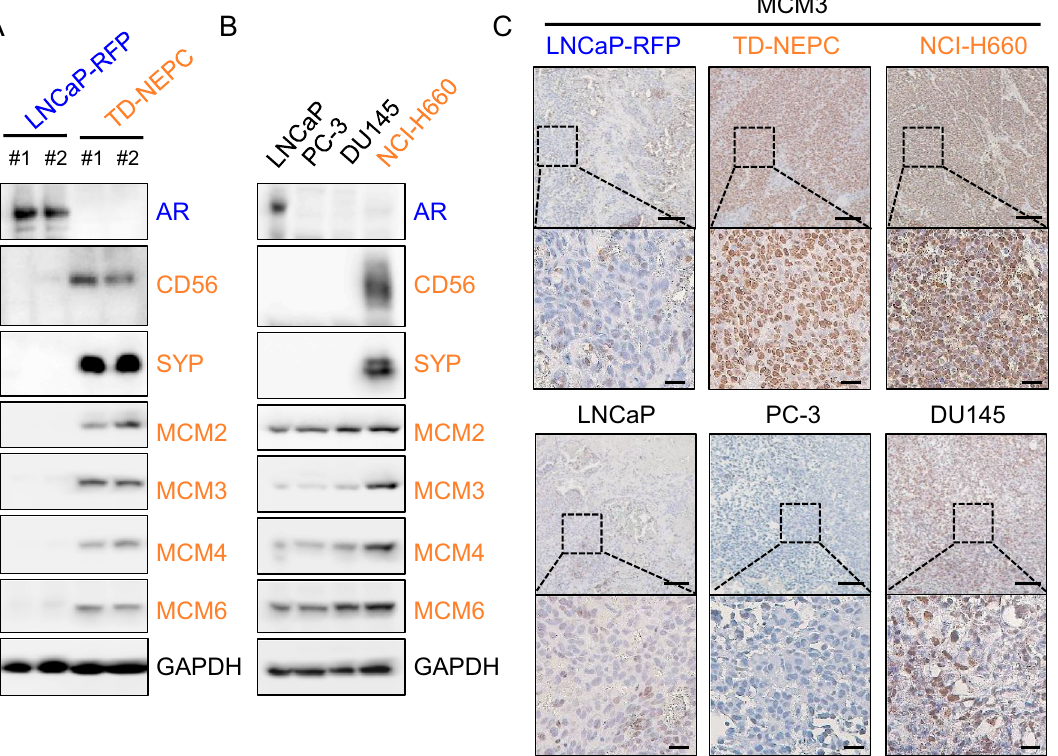
Figure 4. Protein levels of MCM2/3/4/6 are elevated in NEPC cell lines. ( A ) Protein levels of MCM2/3/4/6, AR, two neuroendocrine markers (CD56 and SYP), and GAPDH in LNCaP-RFP and TD-NEPC xenografts were measured by western blot. ( B ) Western blots of MCM2/3/4/6, AR, CD56, SYP, and GAPDH in LNCaP, PC3, DU145, and NCI-H660 (neuroendocrine) prostate cancer cell lines. ( C ) IHC staining for MCM3 in xenograft tumors derived from prostate cancer cell lines. Representative images are shown. Scale bars represent 100 and 20 microns